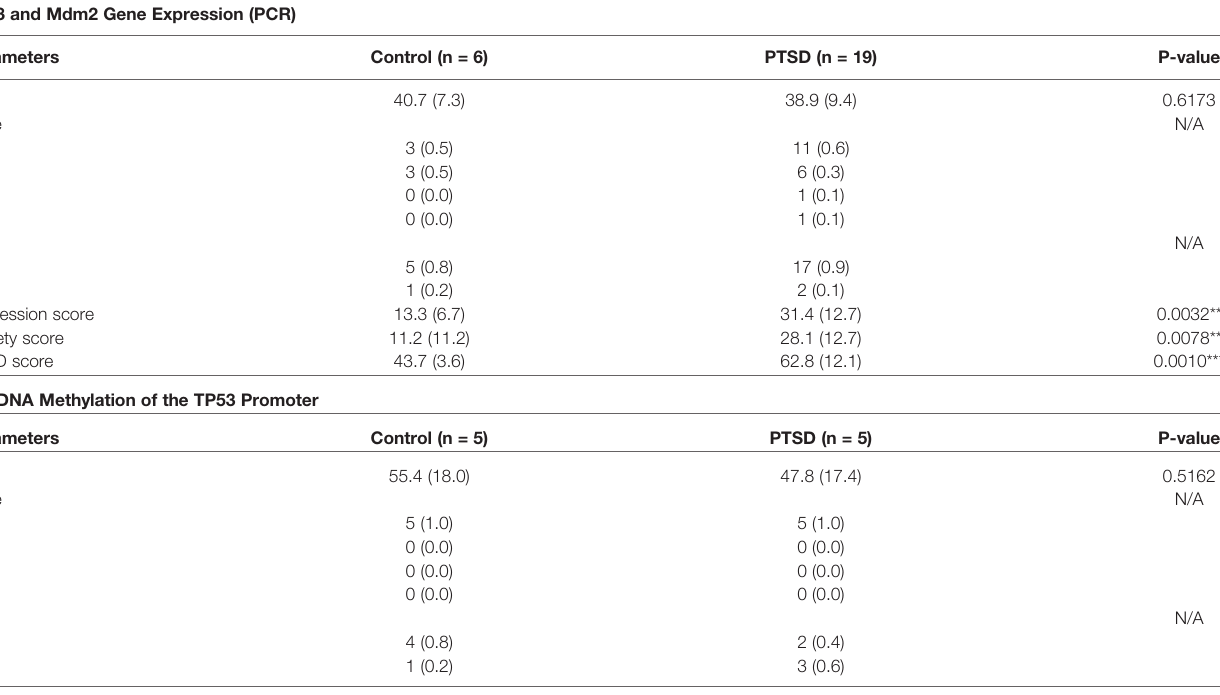
TABLE 1 | Demographics and clinical history of Control and PTSD samples for PCR gene expression and DNA methylation analysis. TP53 and Mdm2 Gene Expression (PCR)